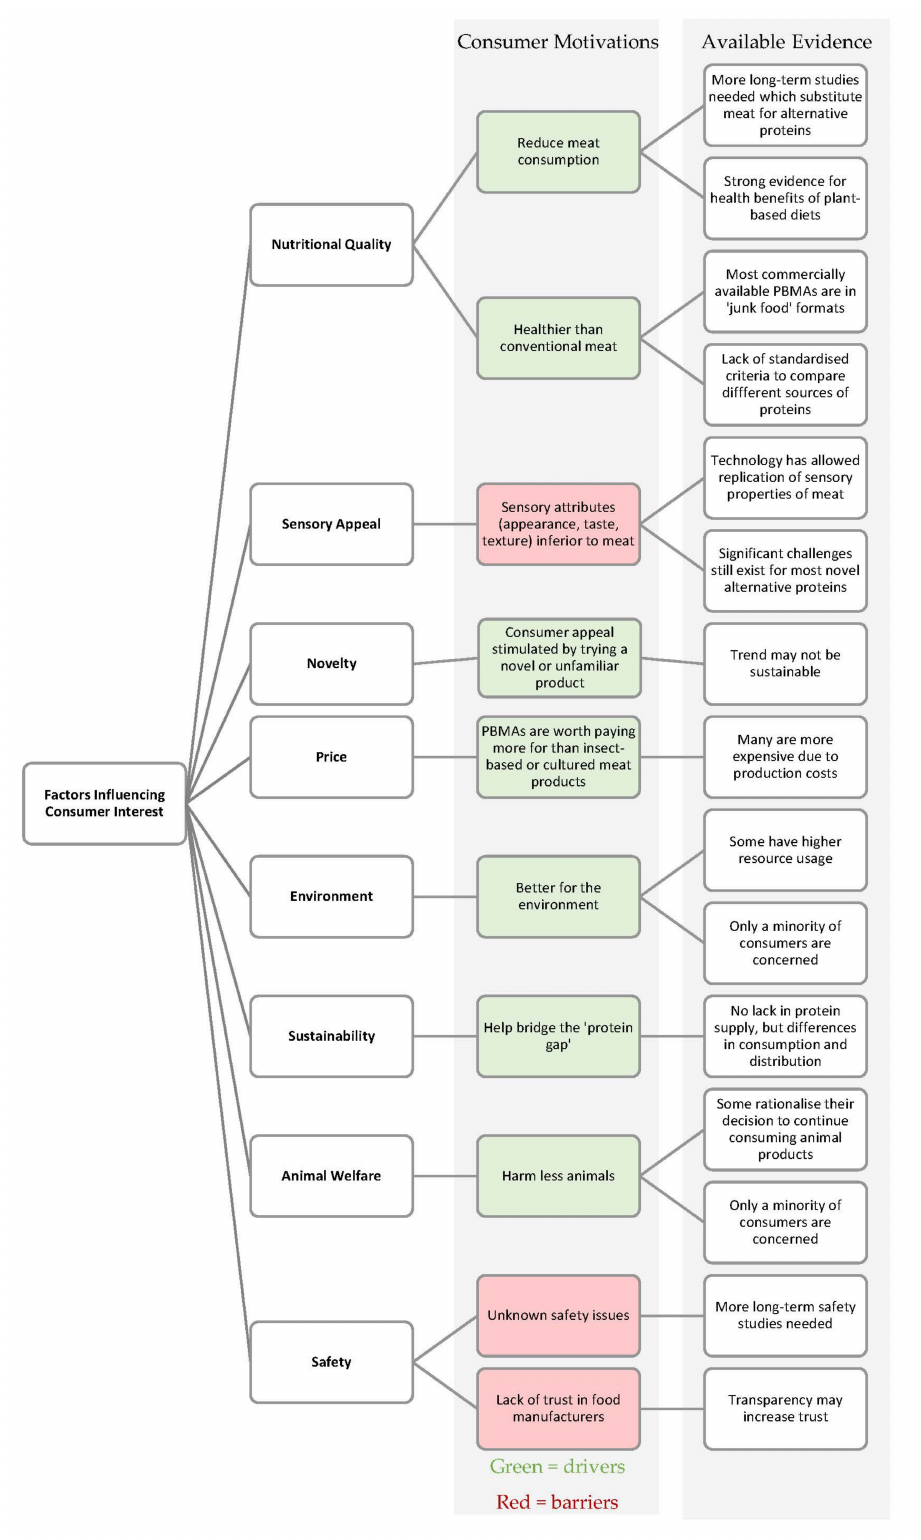
Figure 1. Factors influencing consumer interest in alternative